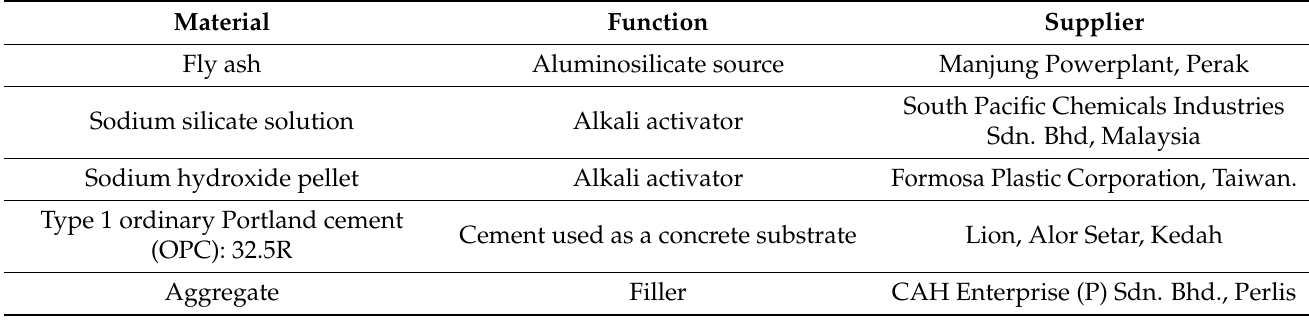
Table 1. Overall summary of materials used for the